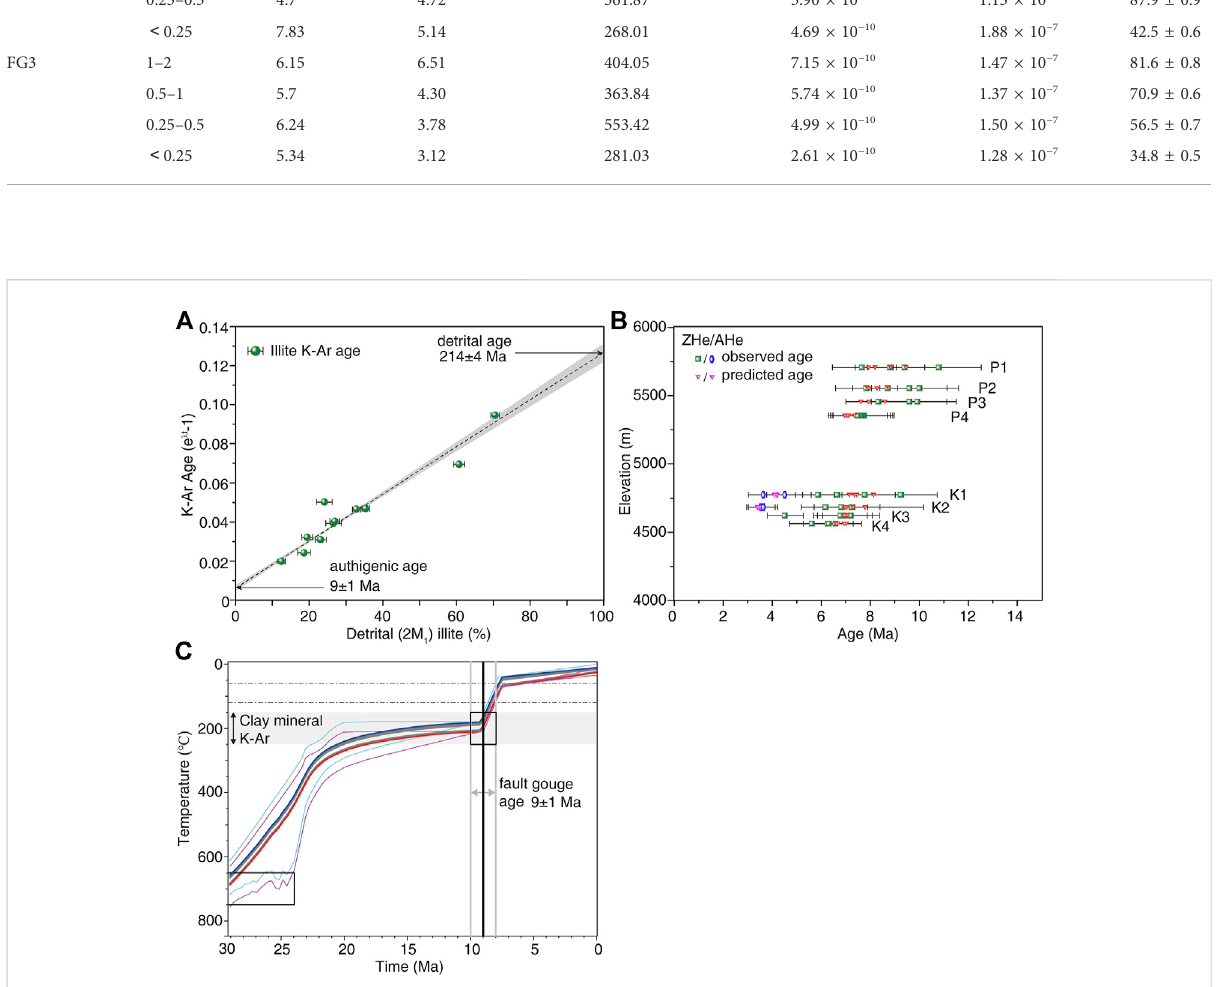
FIGURE 6 Zircon, apatite (U-Th)/He results and fault gouge authigenic illite ages. (A) K-Ar ages correlate with the percentage detrital illite component. Authigenic illiteagesare lateMiocene at9±1 Ma anddetrital illiteagesare lateTriassic at214 ±4 Ma. (B) Age-elevation relationship for thenorthern Chomo Lhari Mountain and southern Chumba Yumco pro fi les, showing both observed and predicted single-grain ages modeled by QTQt. (C) ThermalmodelingresultsofnorthernChomoLhariMountainandsouthernChunbaYumcoleucograniteusingQTQtGallagher(2012)withfault gougedatinginthenormalYadongfault.Thethickblue,grey,andredlinesshowtheuppermost,intermediate,andlowermostsamples,respectively, representing the 95% con fi dence intervals for the uppermost, intermediate, and lowermost thermal histories. The grey box shows the temperature range of K-Ar dating of Clay mineral in fault gouge Grathoff and Moore